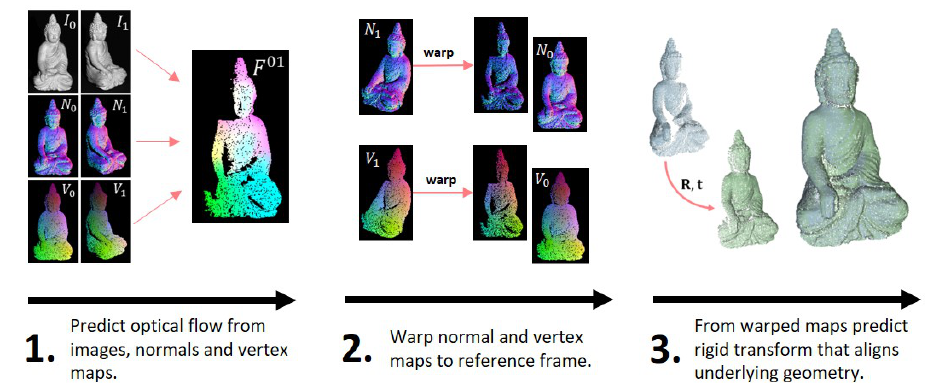
Figure 1. Sketch of the proposed methodology: In a first step, the pixel-wise optical flow is predicted from all available input (images, normals and vertices). In a second step, normal and vertex maps are warped to the reference frame using the predicted flow field. The stacked, warped normal and vertex maps are subsequently processed by another sub-network in order to predict a rigid transformation that aligns the underlying